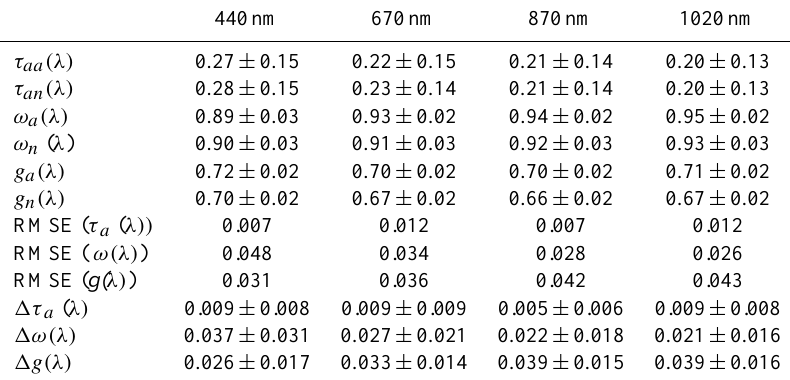
Table 2. Mean values ( ± standard deviation) of spectral aerosol optical depth ( τ a ( λ) ), single scattering albedo ( ω(λ) ) and asymmetry pa- rameter ( g( λ) ); RMSE is the root mean square error and 1 refers to the absolute differences between retrievals obtained by our method and the AERONET code at 440, 670, 870 and 1020nm for all measurements nearly coincident in time during desert dust events from 2005 to 2010. Subscript “ a ” and “ n ” refers to AERONET and our method, respectively. 440nm 670nm 870nm